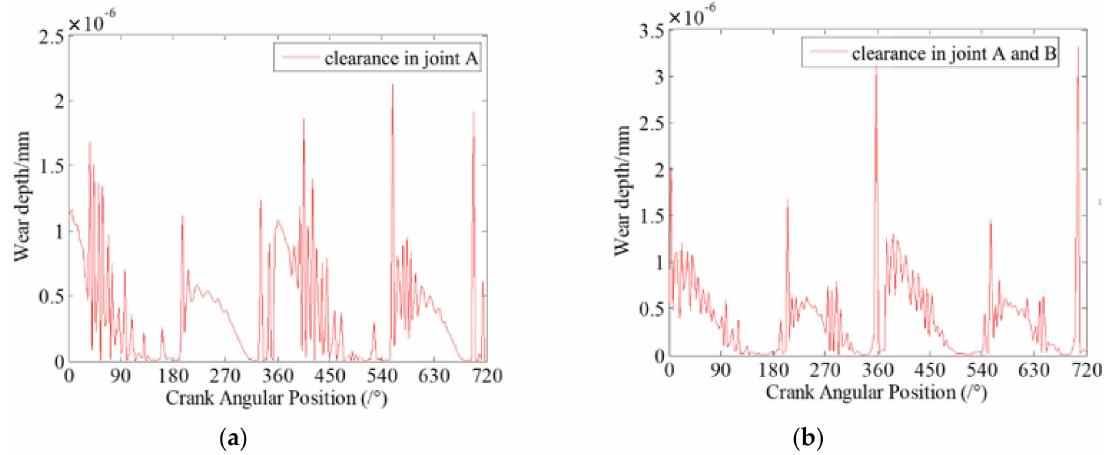
Figure 6. Dynamic wear depth in revolute clearance joint A. ( a ) case 1: there is one clearance joint in the mechanism; ( b ) Case 2: there are two clearance joints in the